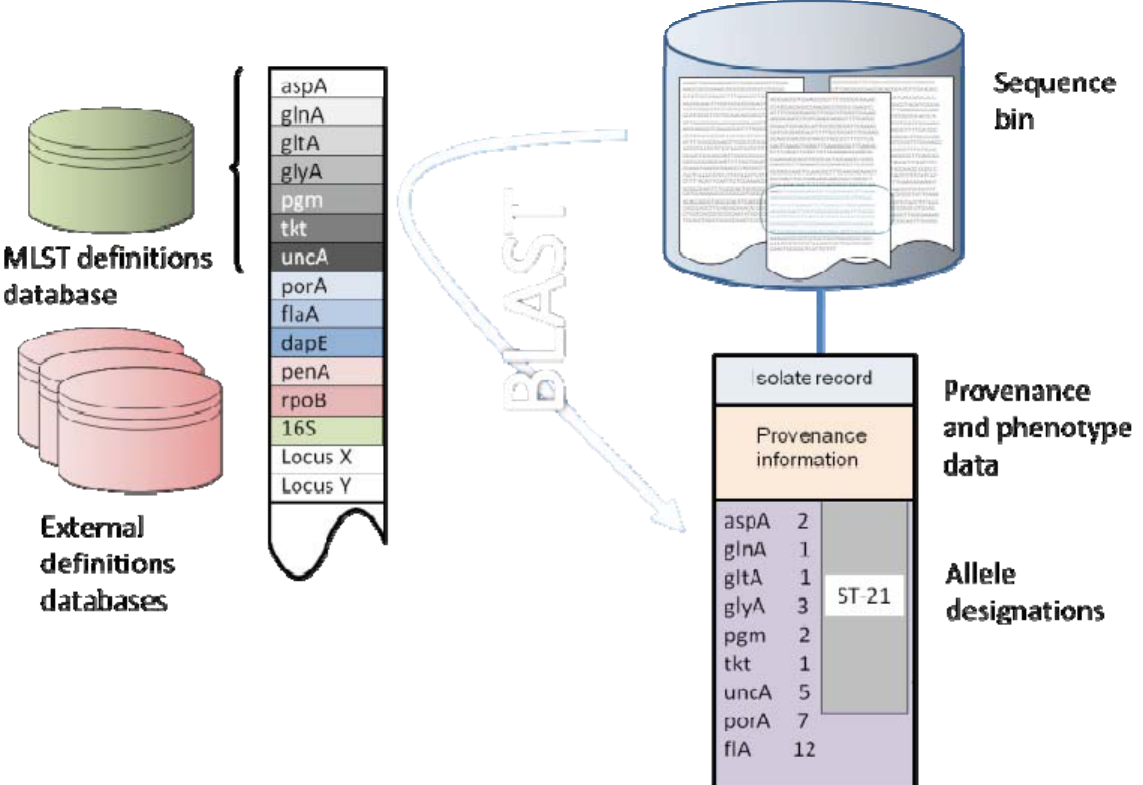
Figure 1. Gene-by-gene analysis of Campylobacter genomes. ( A ) Defined loci are entered into the database, from the finished NCTC 11168 genome; ( B ) Whole genome sequence data, such as contigs generated from parallel sequencing technologies or complete assembled genomes, are entered with isolate provenance and phenotype information; ( C ) Sequences are compared to defined loci using BLAST and allelic variants are tagged. The result is an allelic profile that catalogues variation across the